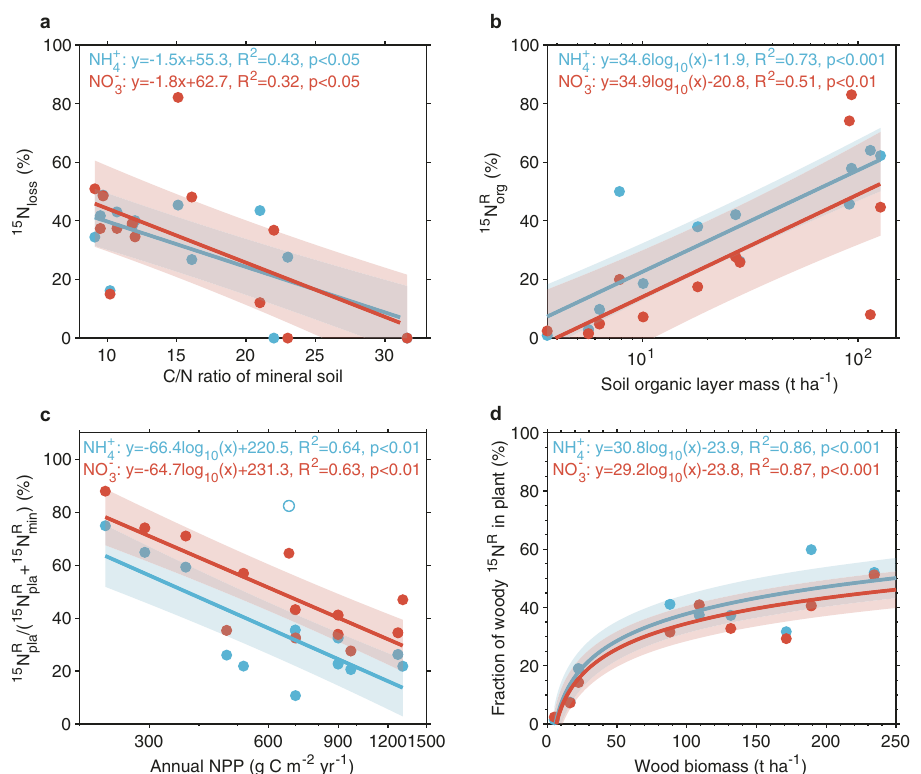
Fig. 2 Relationships used in the scaling up of percent 15 N-tracer recoveries in ecosystem pools or N leaching and gaseous losses. a Percentages of 15 N in leaching and gaseous losses as a function of C/N ratios of mineral soil (0 – 30 cm); b Percentages of 15 N recovered in soil organic layer as a function of soil organic layer mass; c The relationship between 15 N R to the sum of 15 N R and 15 N R and annual NPP; and d Percentages of 15 N retained in plant that is pla pla min allocated to woody biomass as a function of wood biomass. Data shown in each pane are mean values at each site. The corresponding shaded areas indicate the 95% con fi dence intervals of linear regressions. 15 N loss indicates percentage of 15 N leaching and gaseous losses which is the residual of 100 minus 15 N recovery of ecosystem. 15 N R and 15 N R indicate 15 N recovery of plant and mineral soil pools, respectively, and the corresponding shaded pla min areas indicate the 95% con fi dence intervals of linear 2 : 0 2 : 7 Tg N yr − 1 and 2 : 9 3 : 7 Tg N yr − 1 of deposited NH x and NO y , 1 : 3 2 : 0 respectively, were retained in plant biomass (Supplementary times Tg N yr − 1 of deposited NH x and Table 6). In woody biomass, 0 : 7 1 : 0 0 : 5 1 : 0 1 : 2 Tg N yr − 1 of deposited NO y was retained. Retention in soil 0 : 7 organic layer was 2 : 8 3 : 6 Tg N yr − 1 for NH x and 2 : 4 3 : 1 Tg N yr − 1 for 2 : 3 1 : 8 NO y whereas retention in mineral soil was 4 : 6 6 : 0 Tg N yr − 1 for 3 : 3 NH x and 3 : 2 4 : 3 Tg N yr − 1 for NO y (Supplementary Table 6). 2 : 4